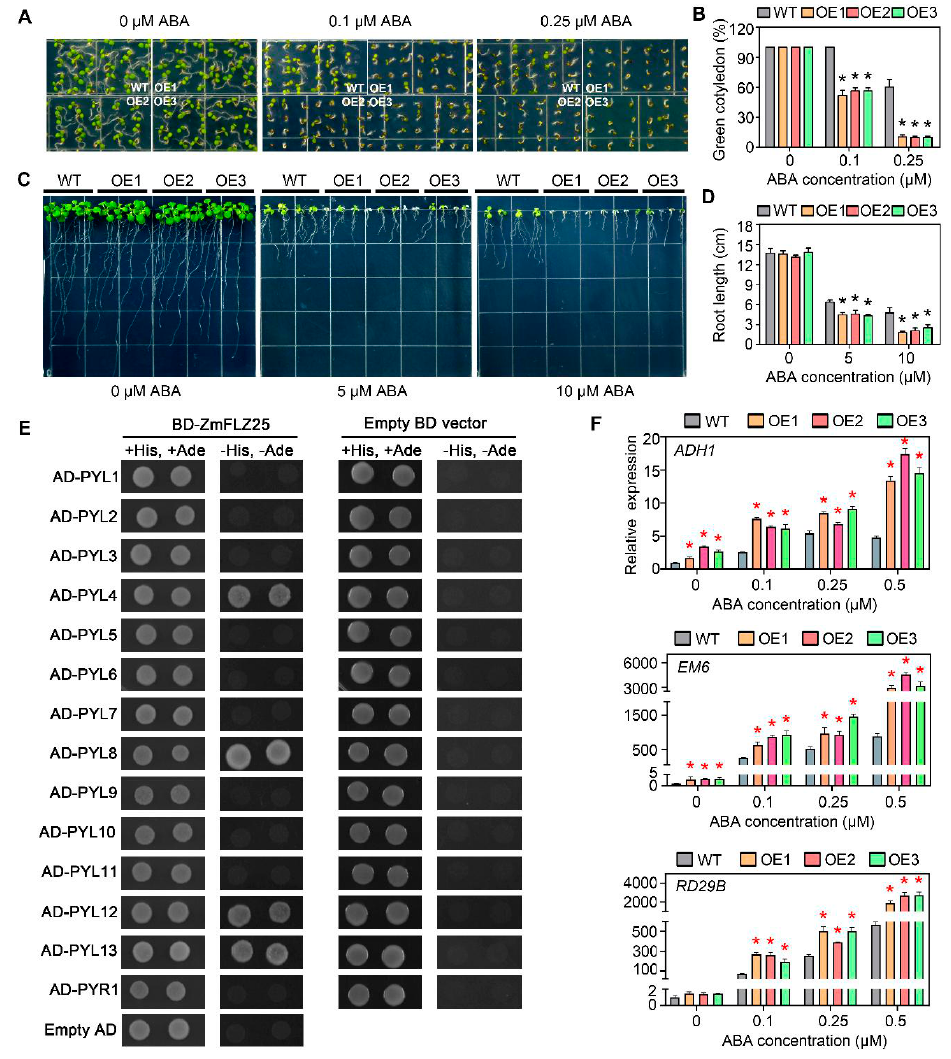
Figure 6. Overexpression of ZmFLZ25 in Arabidopsis resulted in the hypersensitivity of plant to ABA. ( A ) Overexpression expression of ZmFLZ25 in Arabidopsis confers plant sensitivity to ABA 5. days after imbibition. The OE1, OE2 and OE3 represent three different ZmFLZ25- overexpression lines. ( B ) The cotyledon greening rate of WT and OE lines were counted after ABA treatments. Approximately approximately100 seeds were counted for each genotype at 5 days of growth on 1/2 Murashige & Skoog (MS) medium plate, data represents three biologically replicates. ( C ) Ectopic expression of ZmFLZ25 in Arabidopsis resulted in enhanced root growth inhibition in response to ABA treatment. WT and overexpression seedlings were grown on 1/2 MS plate for 2 days and subsequently transferred to plates containing 5 µ M and 10 µ M ABA for 7 days. ( D ) Statistics of the root length of WT and OE lines after ABA treatments corresponding to ( C ). ( E ) Protein interactions between ZmFLZ25 and Arabidopsis ABA receptors by yeast two hybrid assay. ( F ) The expression of ABA-responsive genes ( ADH1 , EM6 , RD29B ) ( y -axis) in Arabidopsis under treatments with different concentrations of ABA ( x -axis) in WT and OE lines. The relative gene expression levels were normalized to the internal gene AtUBQ . All the data are the mean ± SEM from three independent experiments. The asterisks indicated significantly differences between WT and OE lines as determined by t -test ( p -value < 0.05).